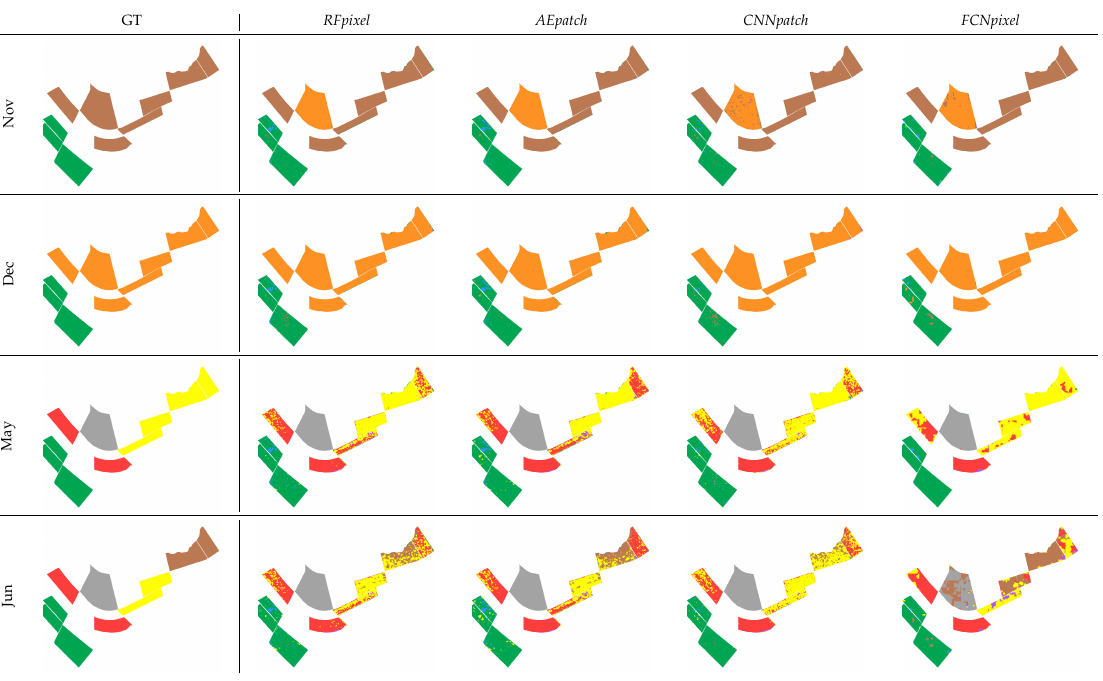
Figure 12. Maps of classification results of Protocol II for selected areas. GT stands for ground truth. Same color legend as in Figure 6.